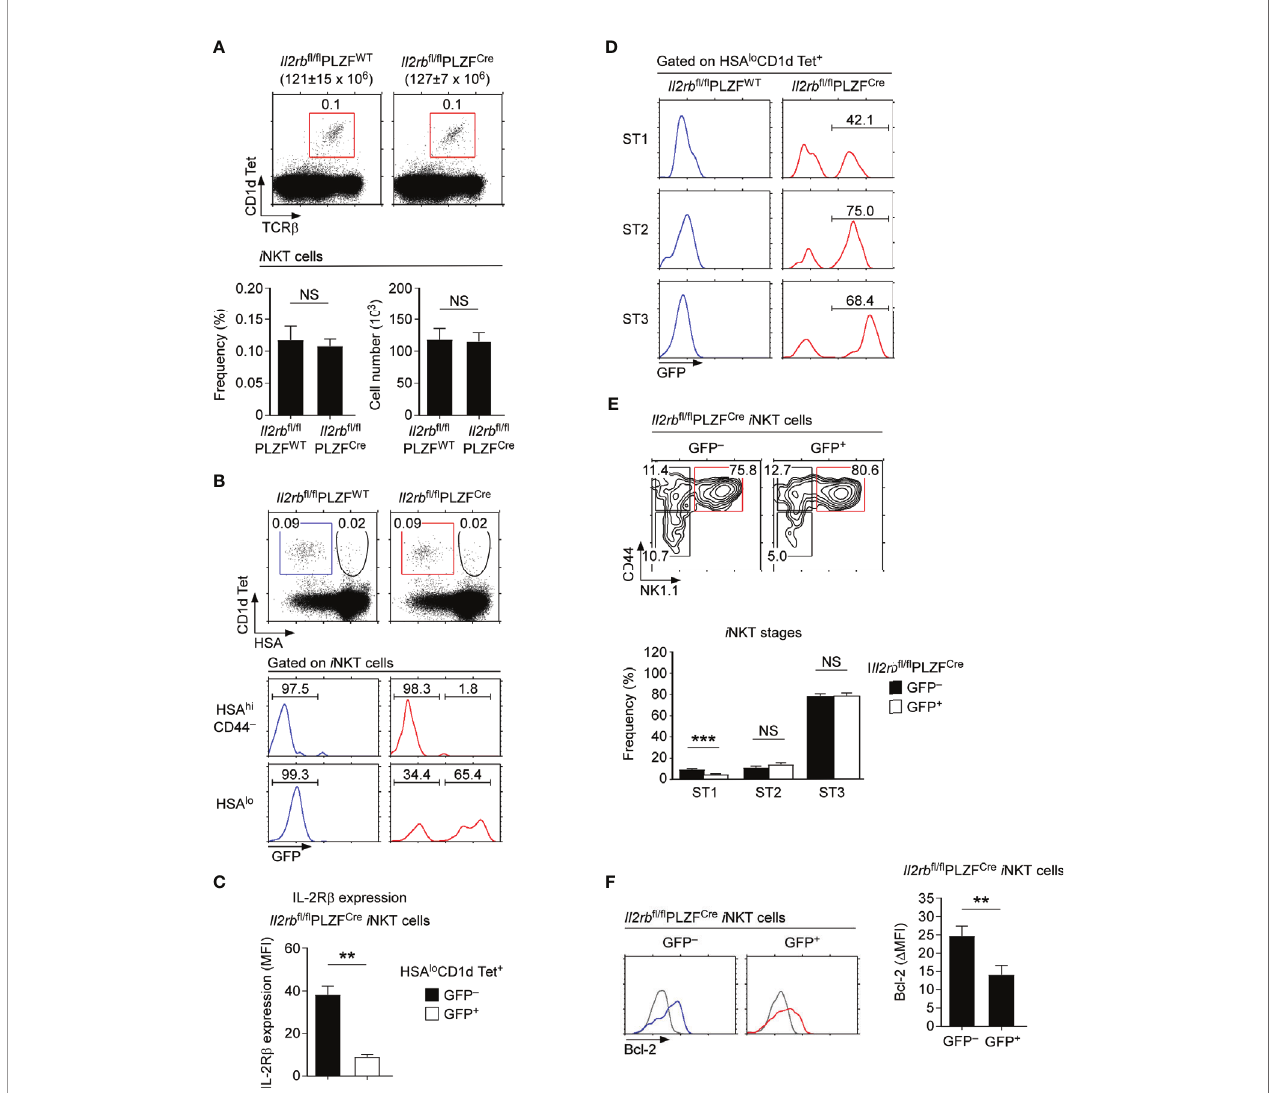
FIGURE 2 | i NKT cell generation and differentiation in IL-2R b - fl oxed PLZF-Cre mice (A) Frequency and number of thymic i NKT cells in Il2rb fl / fl PLZF Cre and Il2rb fl / fl